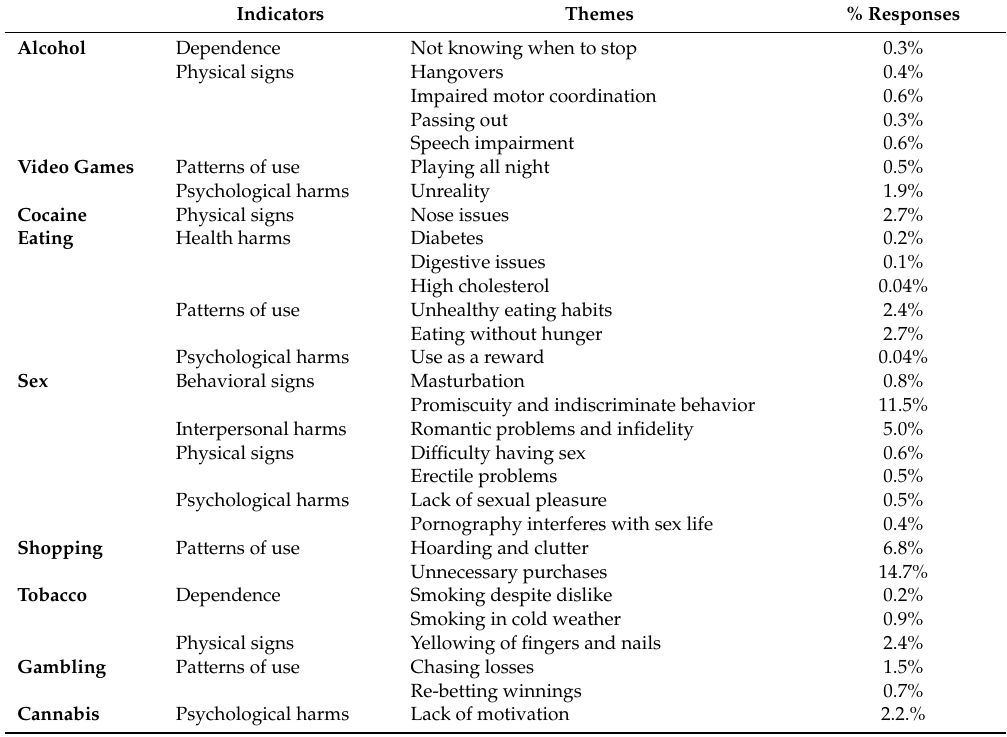
Table 5. Unique themes nominated by people with lived experiences for specific